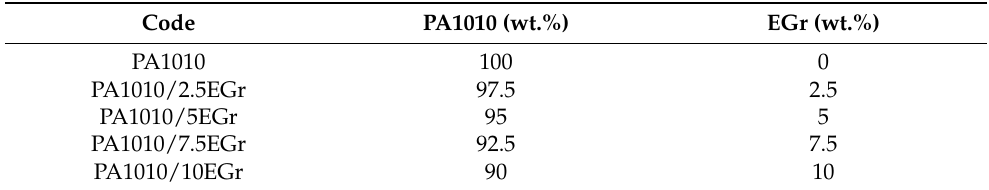
Table 1. Summary of compositions according to the weight content (wt.%) of PA1010 and different proportions of expandable graphite